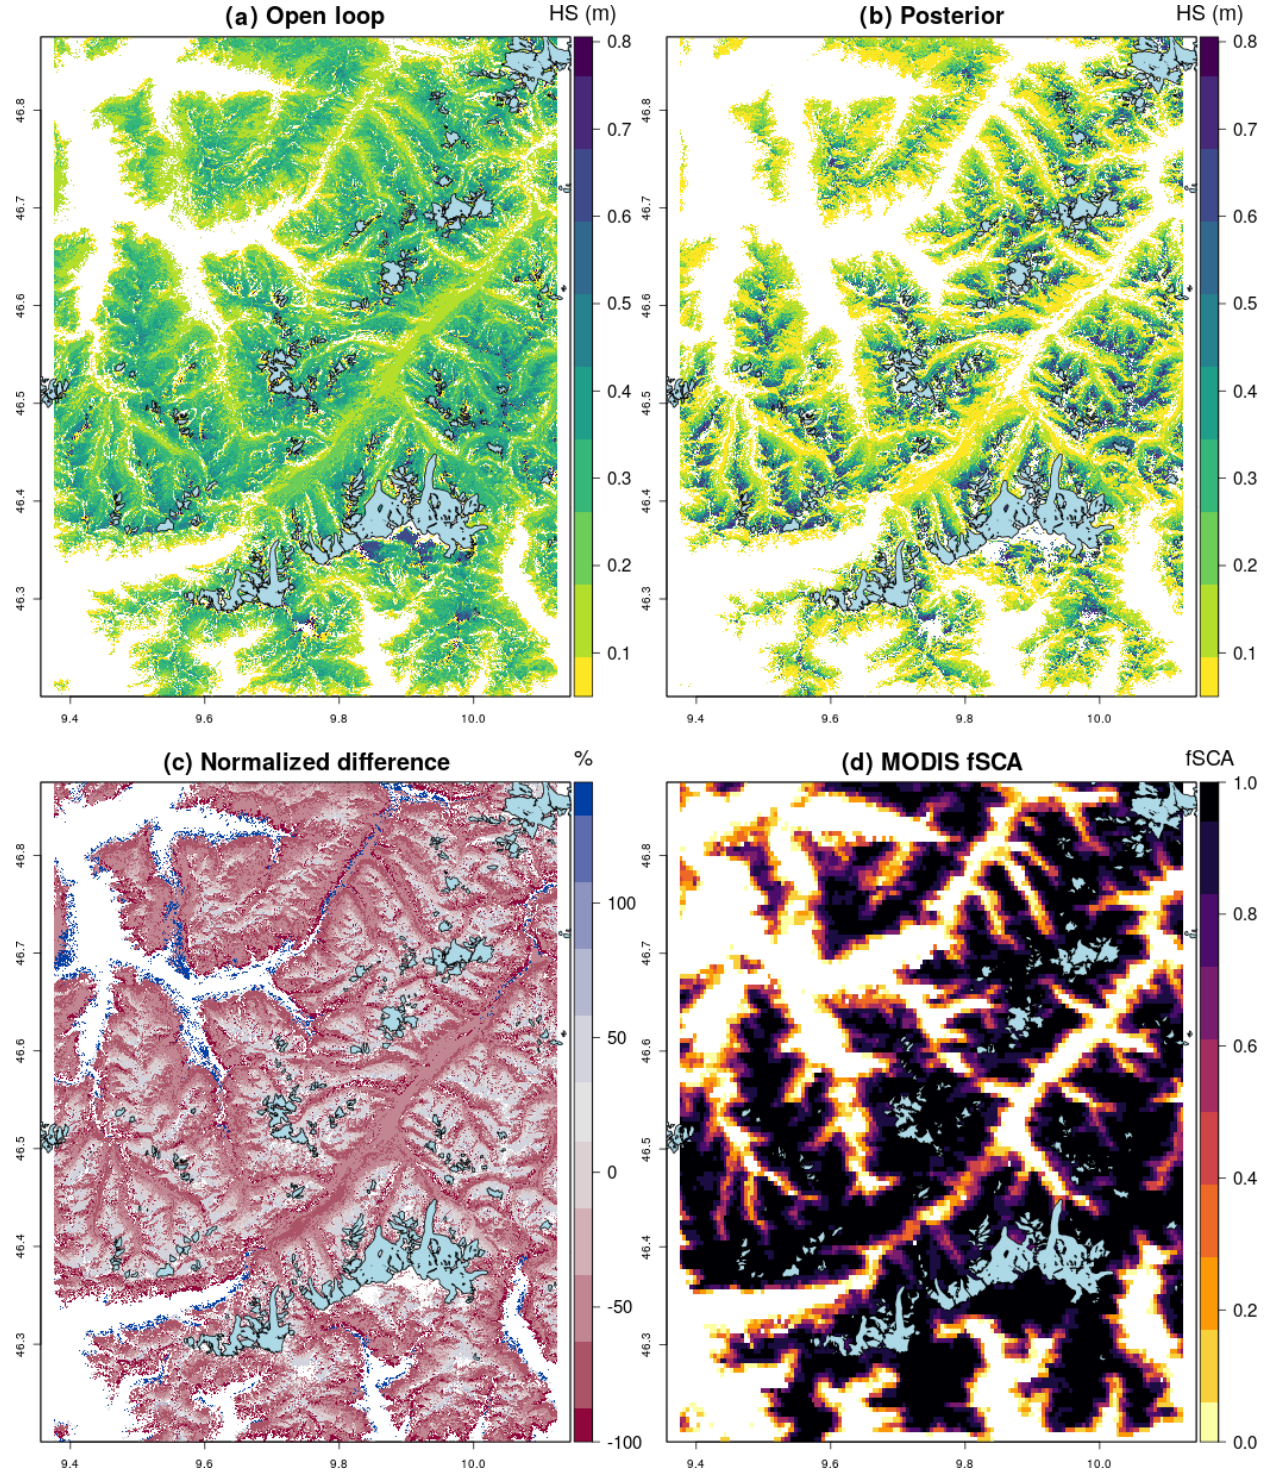
Figure 10. The mean HS for December 2016, showing the (a) open loop compared to (b) posterior. (c) The difference plot shows how DA has reduced the low-elevation snow height relatively more than the high-elevation snow height. Variability has been increased. Snow-free valley bottoms in panel (b) show an improved match to (d) MODIS Obs and that the increased spatial variability is realistic.